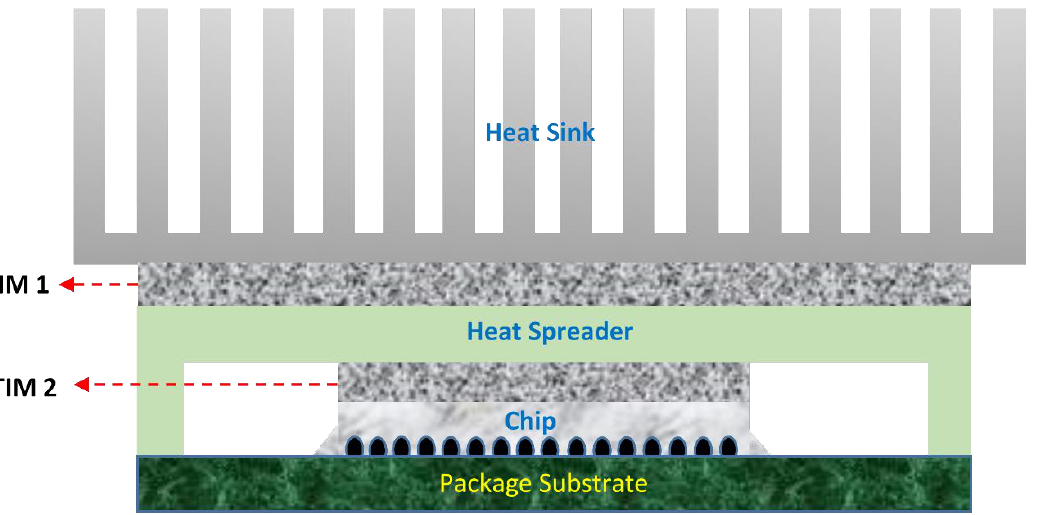
Figure 1. A typical structure of thermal interface materials (TIMs) used in microelectronic packaging .